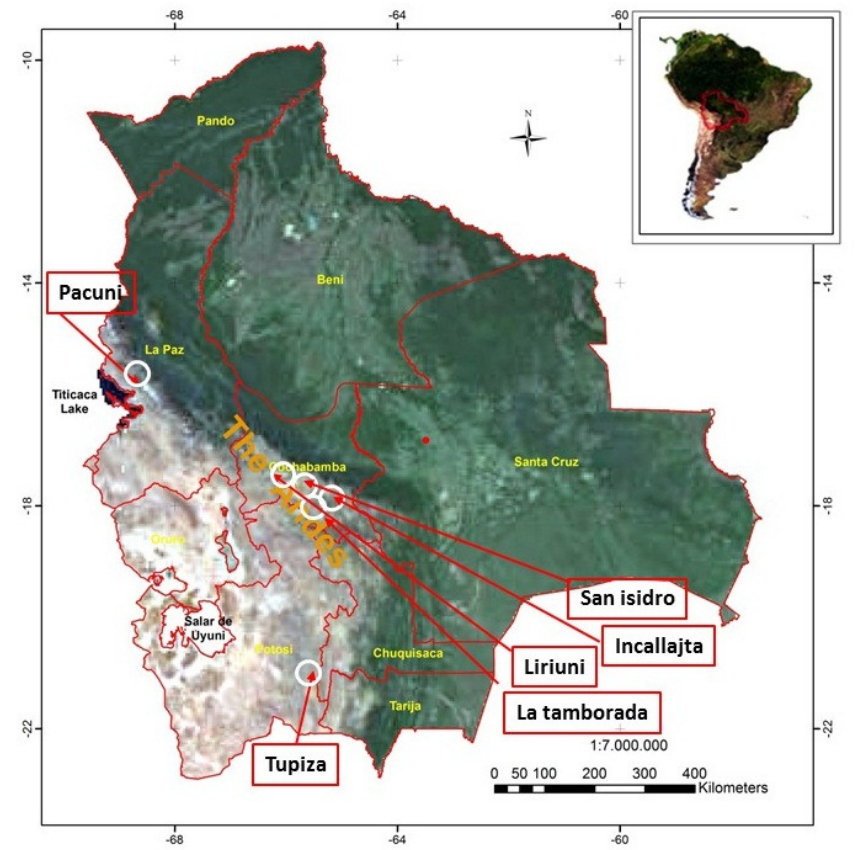
Figure 1. Map localization of the collection samples points of potato wild relatives in the Andean region of Bolivia for virus analysis